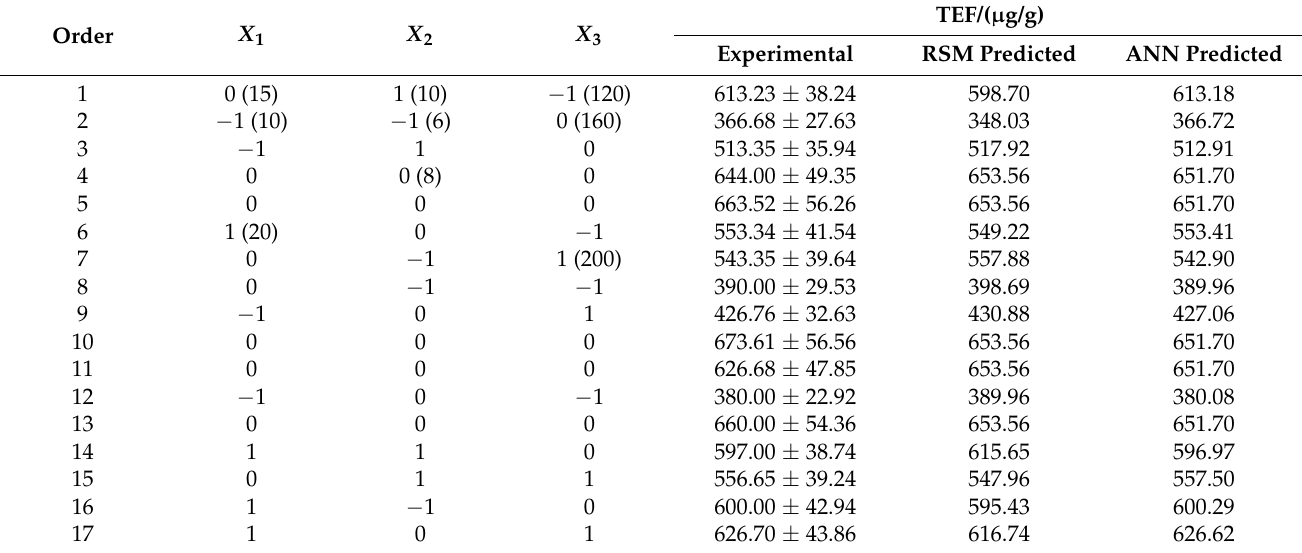
Table 2. Experimental design and results of BBD.